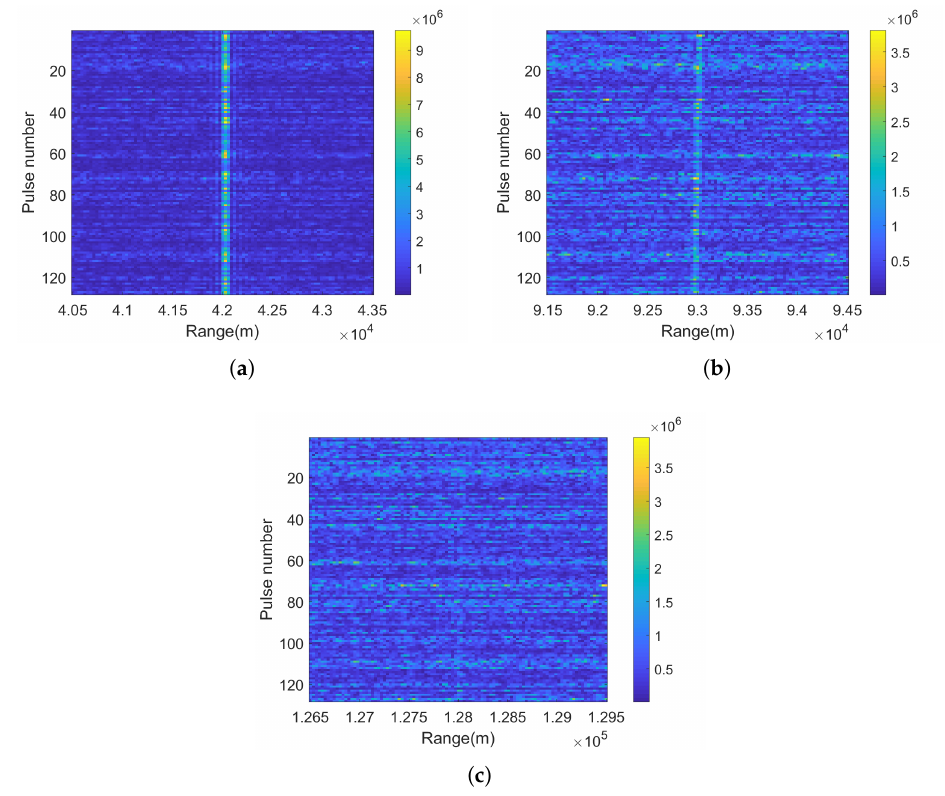
Figure 17. Time-range map of three